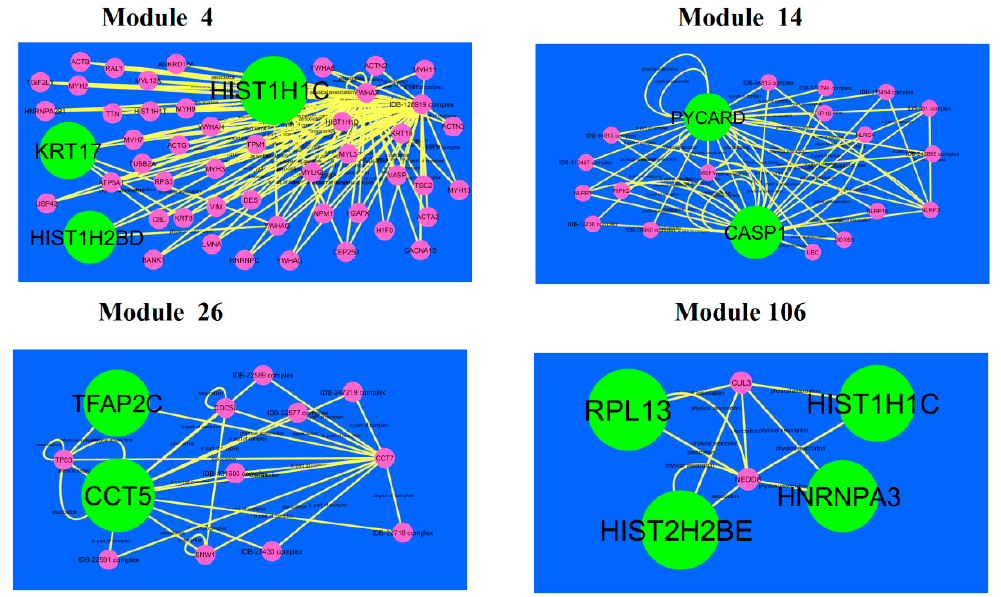
Figure 10. Modules in PPI network. Thedark green round shape nodes denote the up-regulated genes. Pink dots are also genes which are not hub or differential expressed genes. Yellow curve lines is interaction with adjutant genes